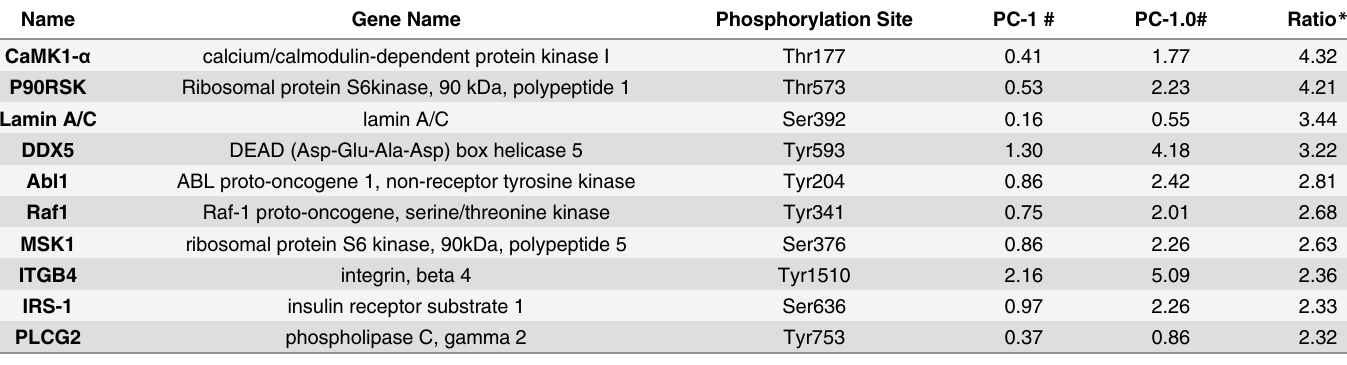
Table 1. The top ten up-regulated genes in highly invasive and metastatic cells (PC-1.0) compared to weakly invasive and metastatic cells (PC-1).